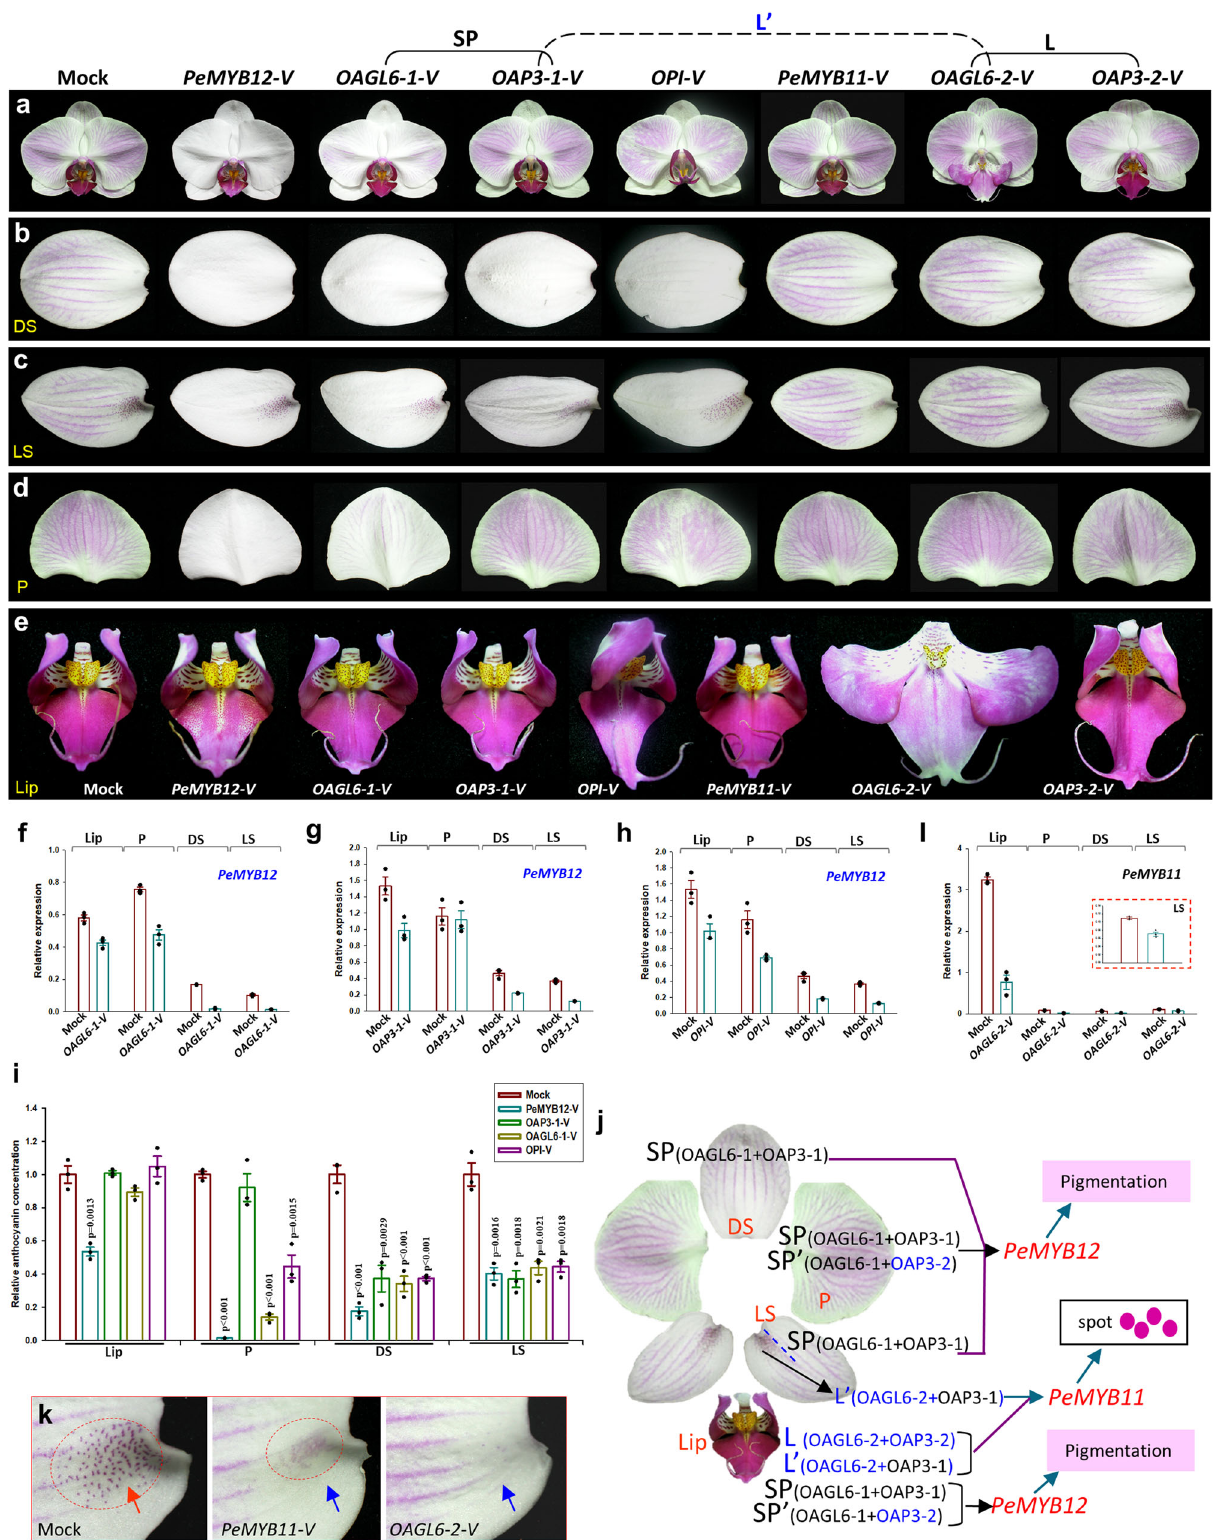
(Supplementary Fig. 6) Phalaenopsis fl owers. This result supports that orchid B class proteins (OAP3-1 + OPI) suppress the senescence of sepals/petals (Fig.